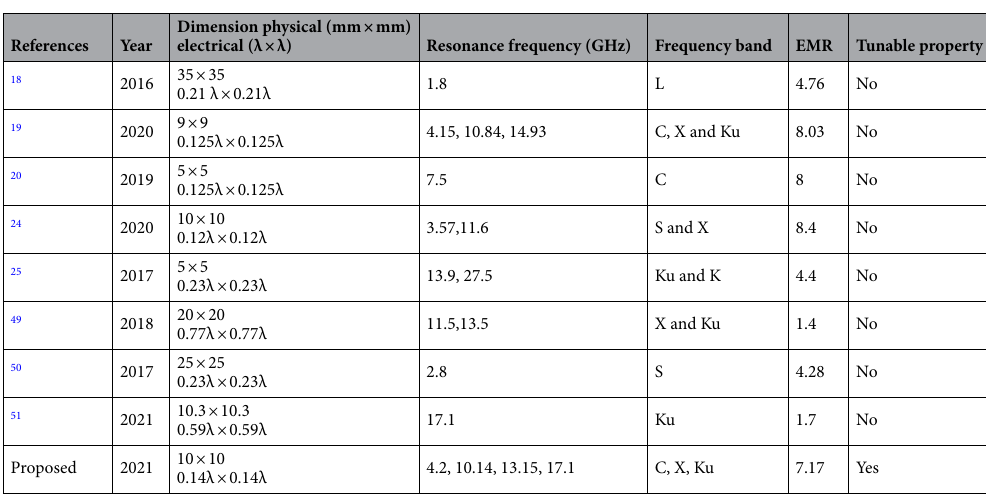
Table 5. Performance comparison of the proposed MTM with other states of arts (comparison is made based on the physical and electrical dimensions, resonance frequency, covering band and